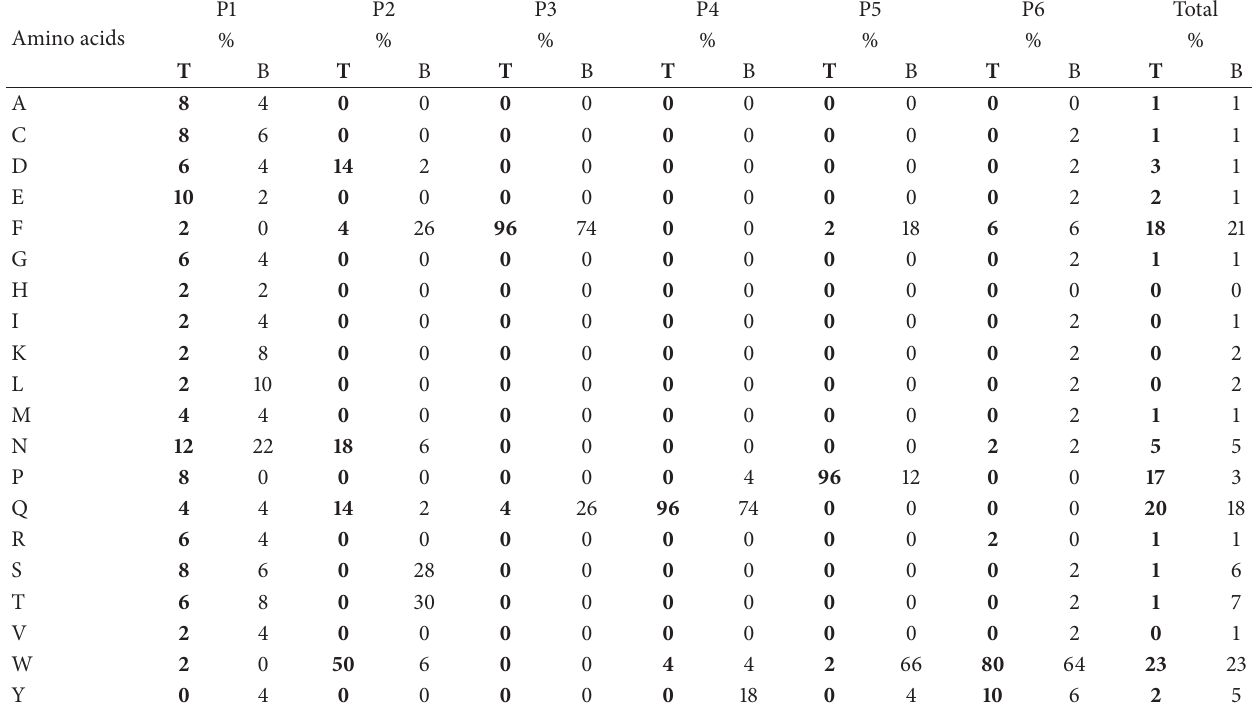
Table 2: Structural analysis of the top (T, bold) and bottom (B, regular) 50 ranked hexapeptides. P: position in sequence, %: amino acid occurrences percentage in top or bottom hexapeptides.